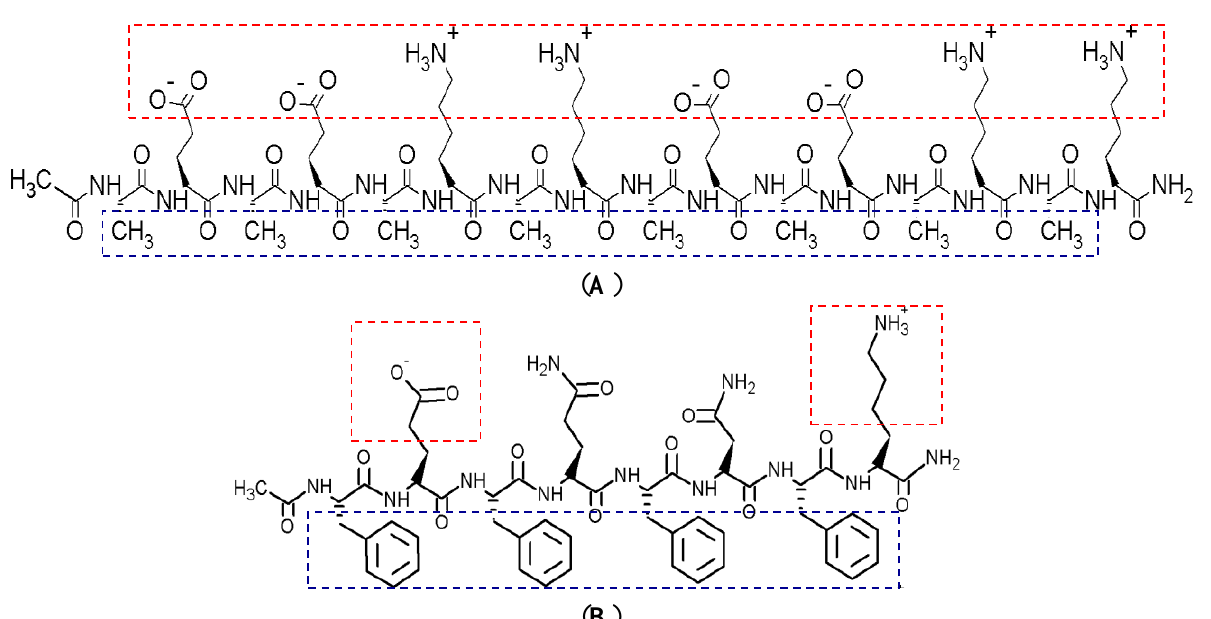
Figure 1. Molecular structure of ( A ) EAK16-II (Ac-AEAEAKAKAEAEAKAK-NH ( B ) AAP8 (Ac-FEFQFNFK-NH blue box regions indicate the charged and hydrophobic residues,